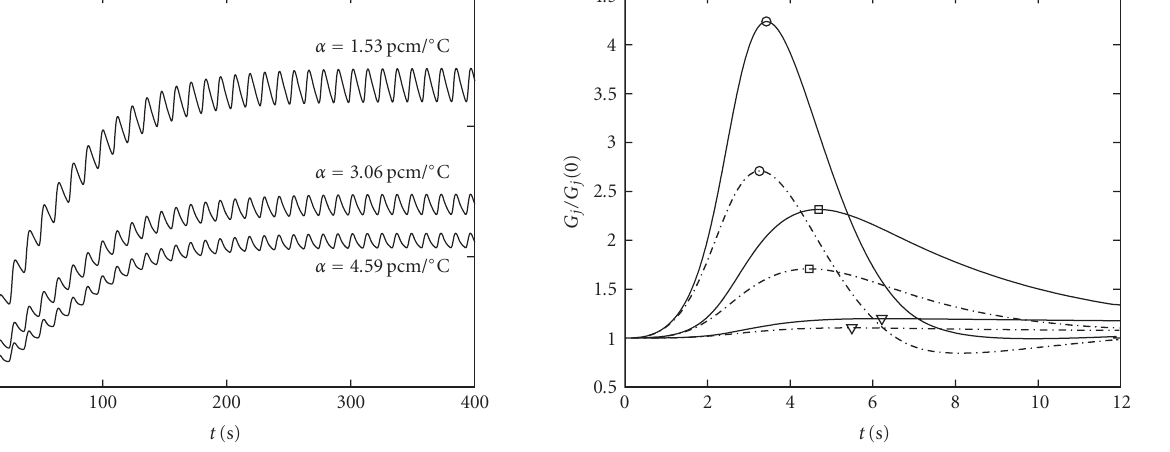
Figure 7: Precursor concentration for the first ( ◦ ), third ( (cid:2) ), and fifth ( ∇ ) families during the first period of oscillation. Two di ff er- ent values of feedback coe ffi cient are considered: α = 1 . 53 pcm/ ◦ C (solid lines), α = 3 . 06 pcm/ ◦ C (dash-dotted